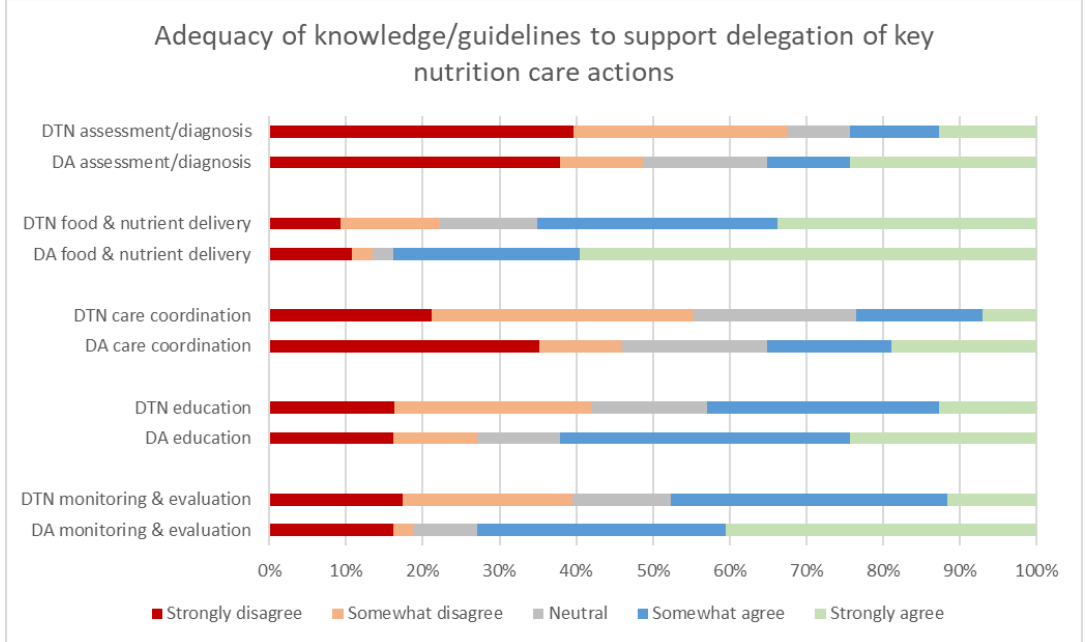
Figure 1. Adequacy of knowledge, guidelines, task instructions and/or tools to support delegation of key nutrition care actions—dietitians’ (DTN) ( n = 85) * and dietitian assistants’ (DA) ( n = 37) responses *. * An additional 1 dietitian completed 4 of the 5 question sub-components.